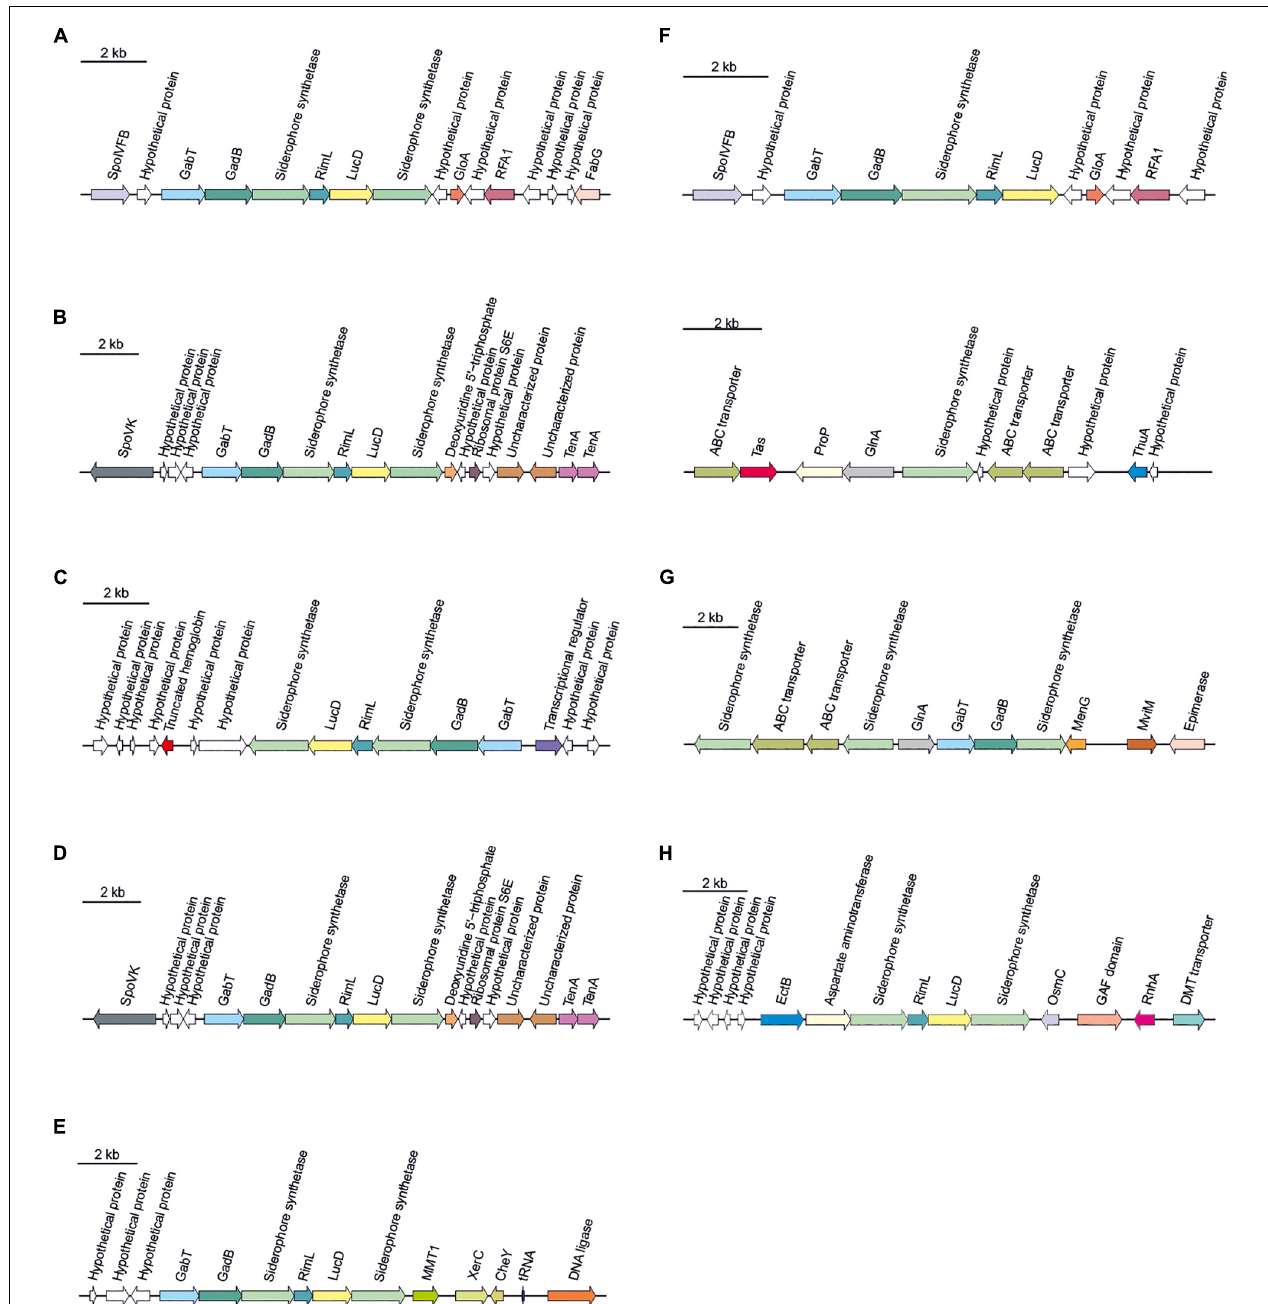
FIGURE 4 | Siderophore biosynthetic gene clusters identified in Halomicroarcula genomes: (A) Strain F13 T , (B) Strain F24A T , (C) Strain F27 T , (D) Strain F28, (E) Halomicroarcula limicola JCM 18640 T , (F) Halomicroarcula pellucida CECT 7537 T , (G) Halomicroarcula salina JCM 18369 T , and (H) Halomicroarcula amylolytica LR21 T